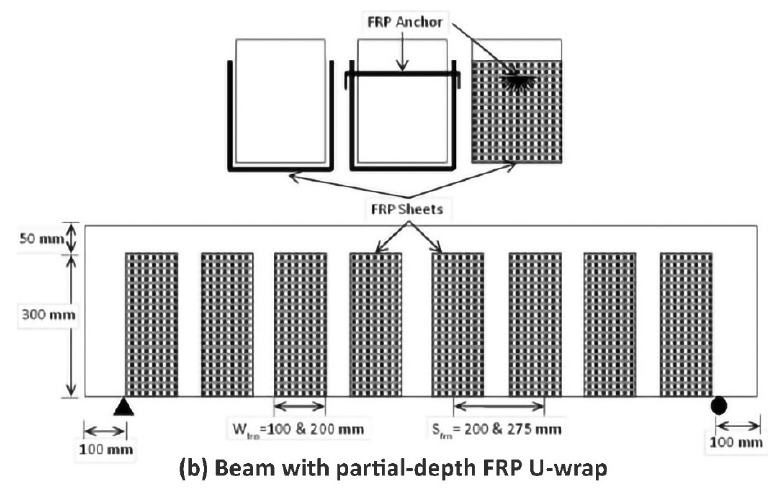
Figure 6. Shear strengthening using a U-wrap scheme [58].